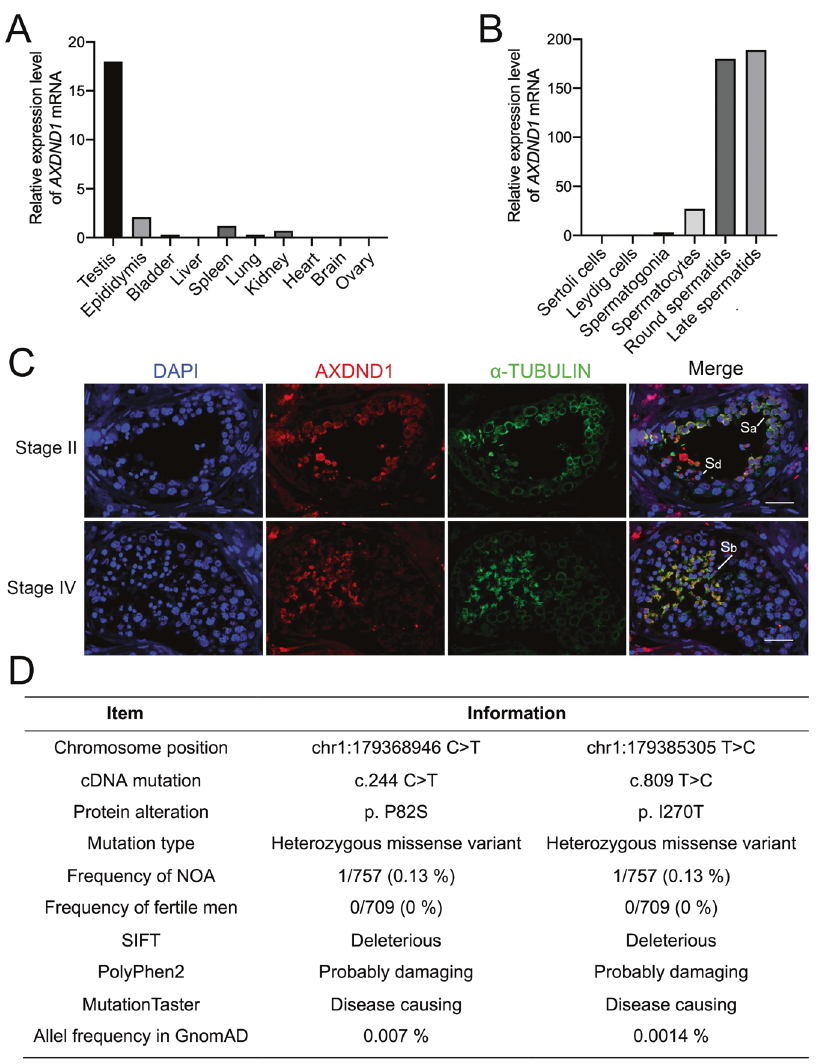
Fig. 1 The expression characteristics of AXDND1 in human testis and clinical mutation screening. A AXDND1 mRNA expression in various human tissues. B AXDND1 expression in different types of human testicular cells. Data in ( A ) and ( B ) were obtained from the Human Protein Atlas. C AXDND1 protein expression in the human testis was determined by co-immuno fl uorescent staining of AXDND1 (red) and α -TUBULIN (green). AXDND1 was highly expressed and colocalized with α -TUBULIN in round spermatids (Sa) in stage II and late spermatids (Sb) in stage IV. Scale bar: 20 µm. D Analysis of AXDND1 variations in NOA